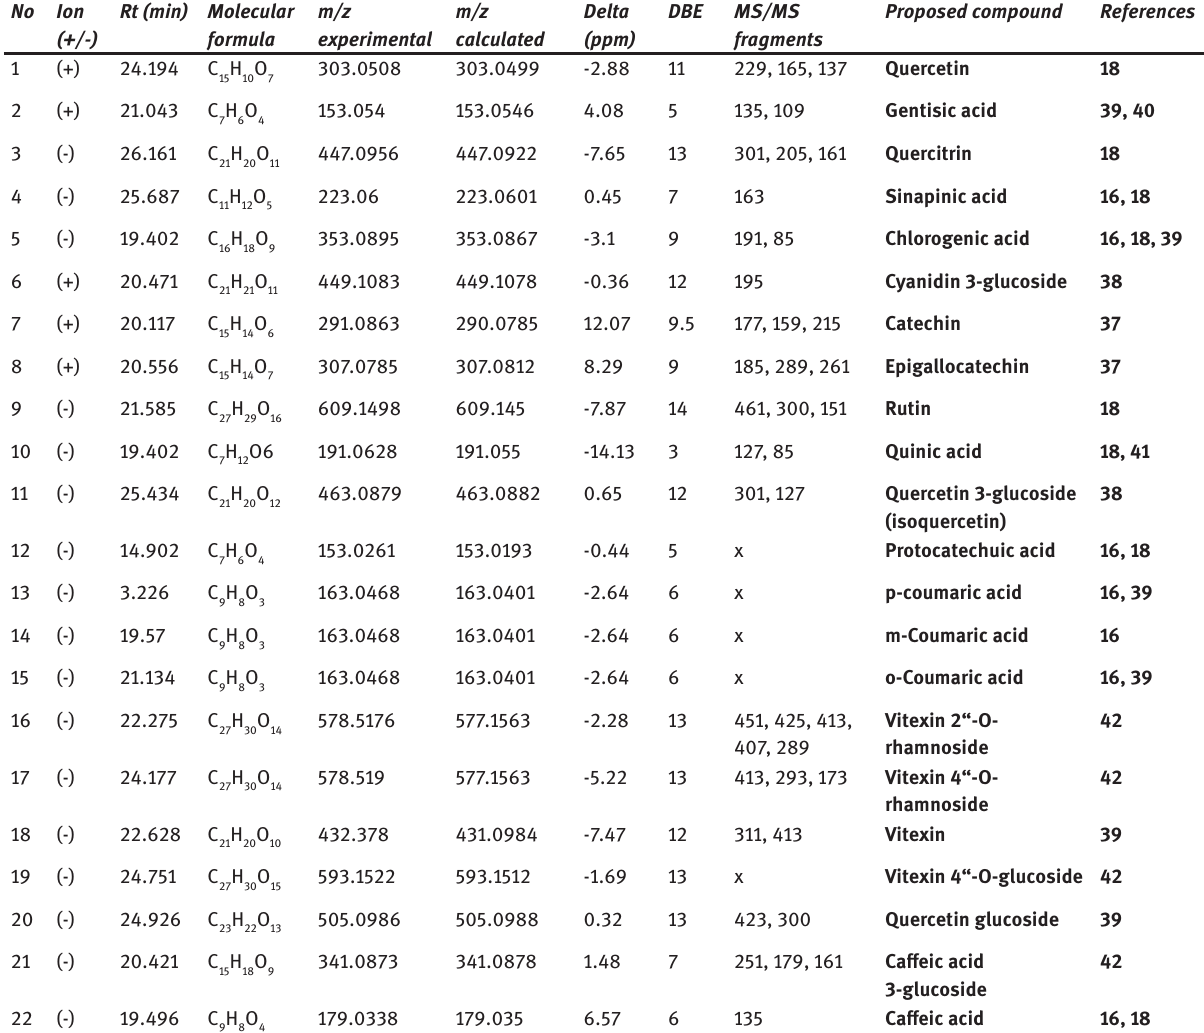
Table 1: LC-MS determination of major constituents from Crataegus almaatensis extracts. ( DBE – double bond equivalent, Rt – retention time, Delta – difference between experimental and calculated masses